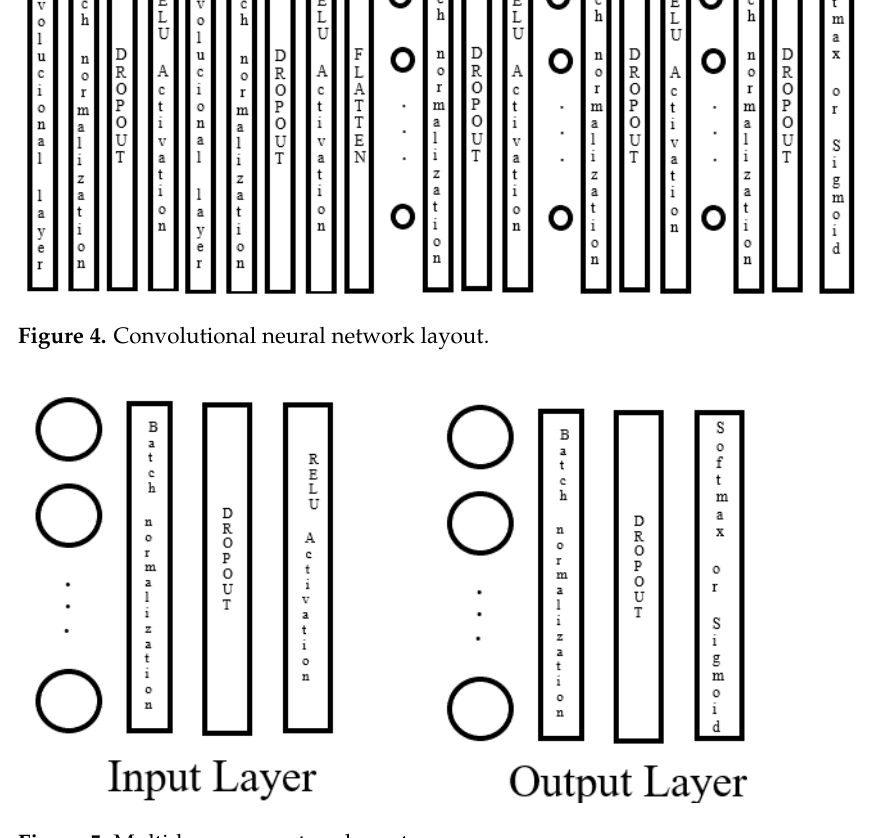
Figure 4. Multi-layer perceptron layout. Figure 5. Multi-layer perceptron